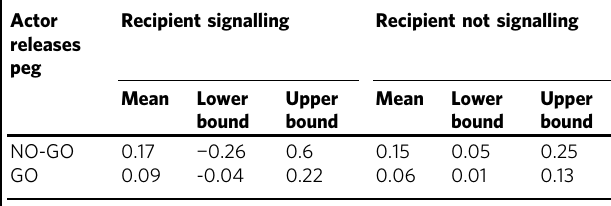
Table 1 Recipient signalling from Tennie et al.